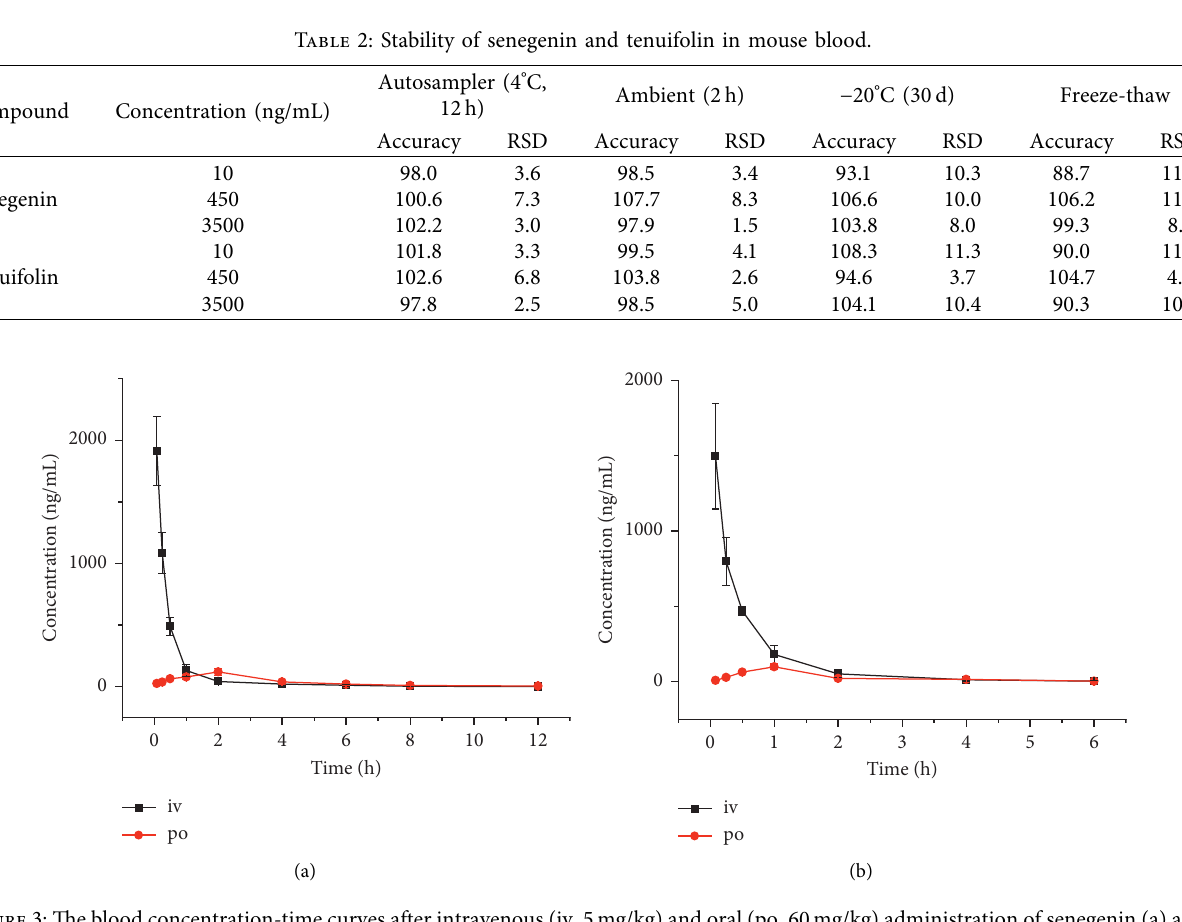
Figure 3: The blood concentration-time curves after intravenous (iv, 5 mg/kg) and oral (po, 60mg/kg) administration of senegenin (a) and tenuifolin (b) in mice. Table 3: The main pharmacokinetic parameters of senegenin and tenuifolin after intravenous (iv) and oral (po) administration in mice.